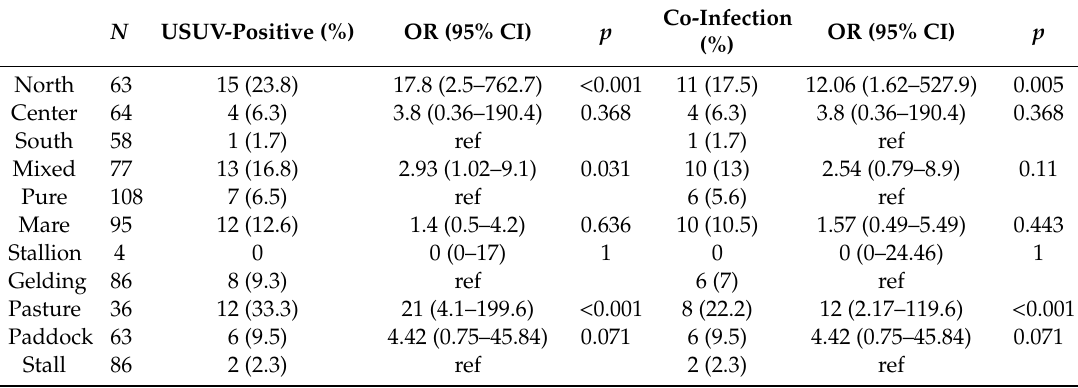
Table 1. Risk factors associated with exposure to West Nile virus (WNV) and Usutu virus (USUV) ( N : number of horses, OR: odd ration, CI: confidence interval, p : p -value, Ref: reference group for groups of the same category, i.e., location, breed,